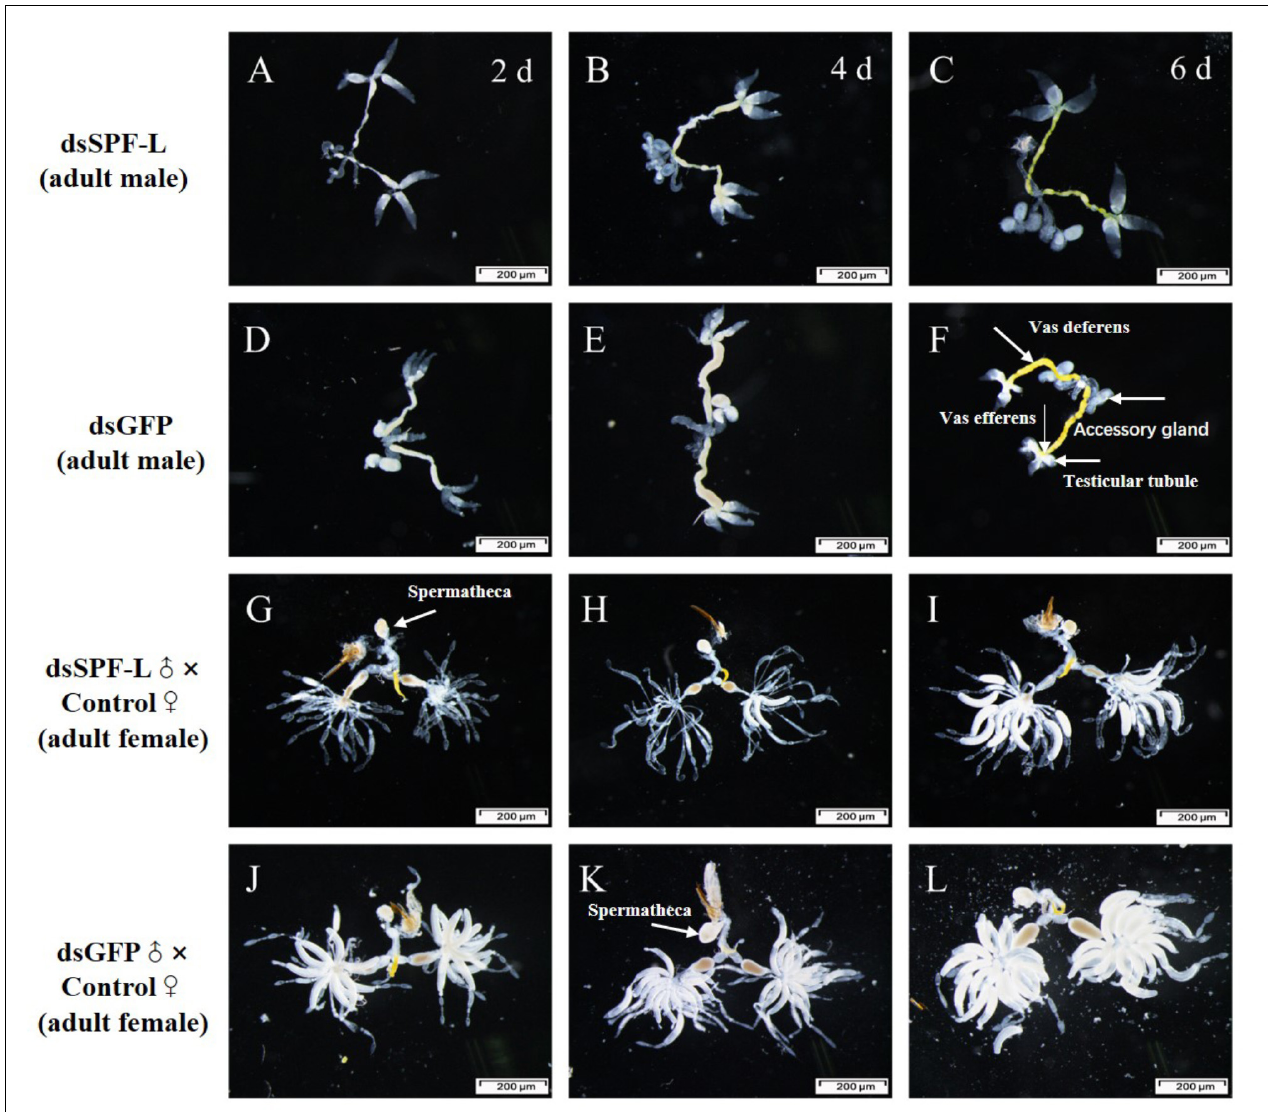
FIGURE 10 | Influence of dsSPF-L-treated male on the IROs of males and their mating partners at 2, 4, and 6 DAE, n ≥ 15. DAE are indicated in upper right corners of panels (A–C) . (A–C) IROs from treated males, just over panels (D–F) , with images of IROs from control males. (G–I) IROs from partners after mating with dsSPF-L-treated males, just atop panels (J–L) with images of IROs from partners of control